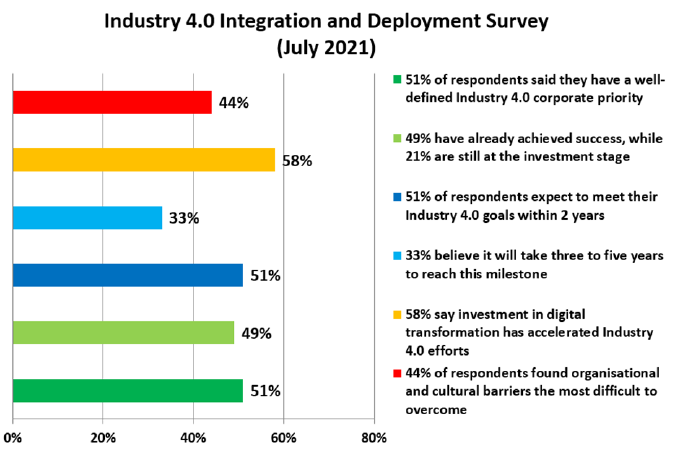
Figure 1. Integration deployment survey.